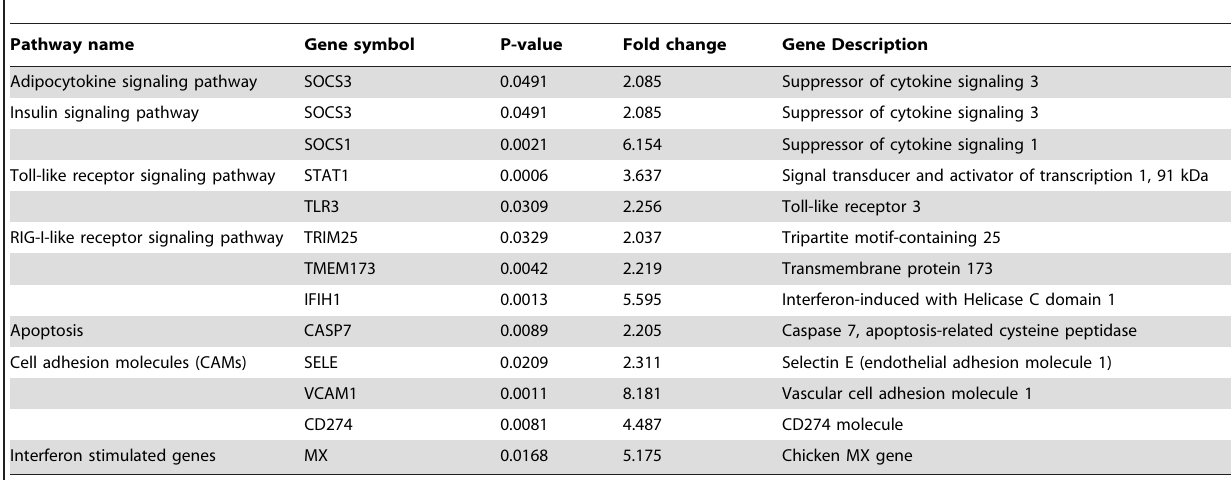
Table 6. Two-fold or more upregulated selected genes in thrombocytes 18 hours pi of chickens with HP VN/1203/K and HP VN/ 1203/E relative to uninfected